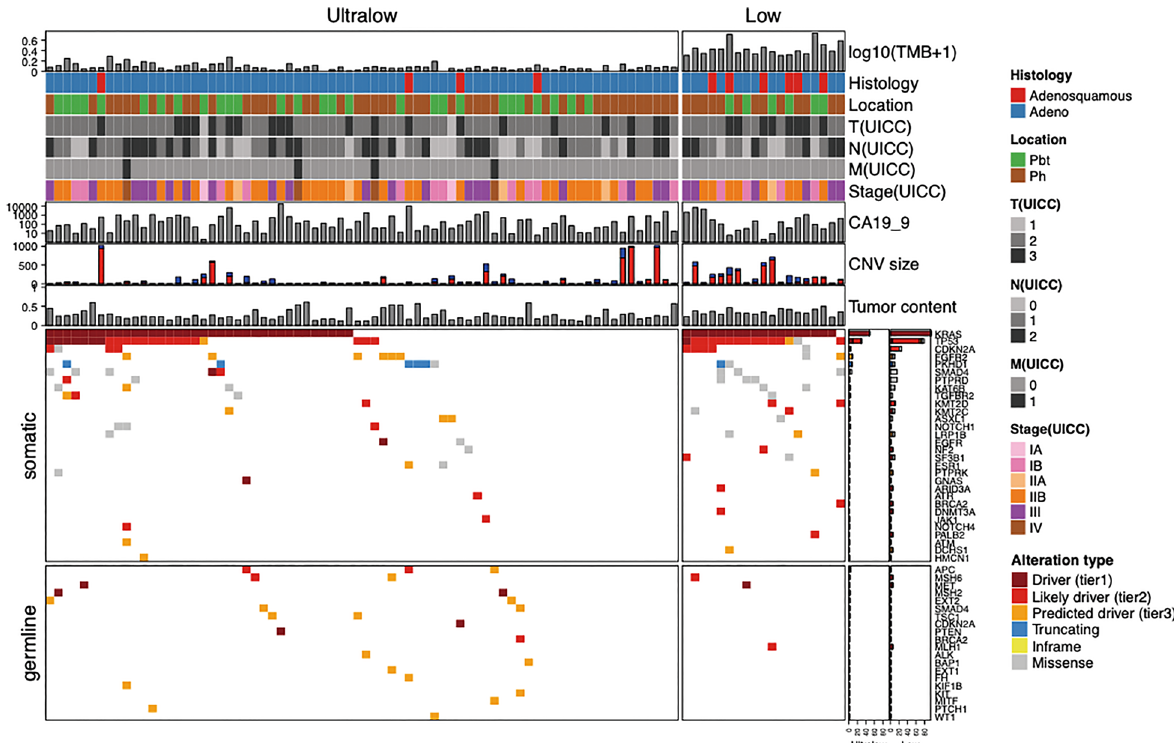
Figure 2. Landscape of genomic alterations according to the TMB classification in pancreatic cancer. The bar graph on the right shows the mutation frequency of each mutated gene. Green represents substitution/Indel mutations, red represents gene amplification mutations, blue represents gene homozygous deletion mutations, yellow represents fusion/rearrangement mutations, and purple represents truncation